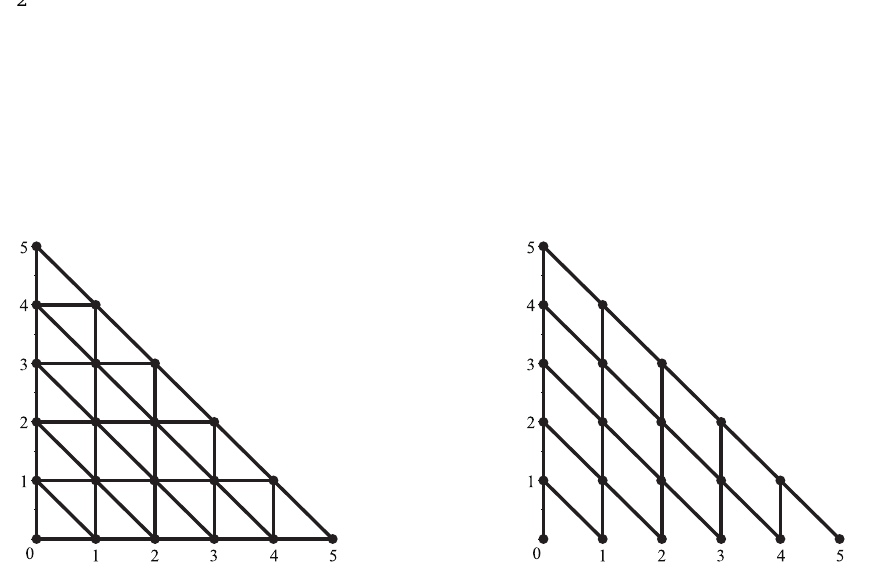
Figure 2: The transition amplitude | f of the circles are proportional to | f ( π at . 2